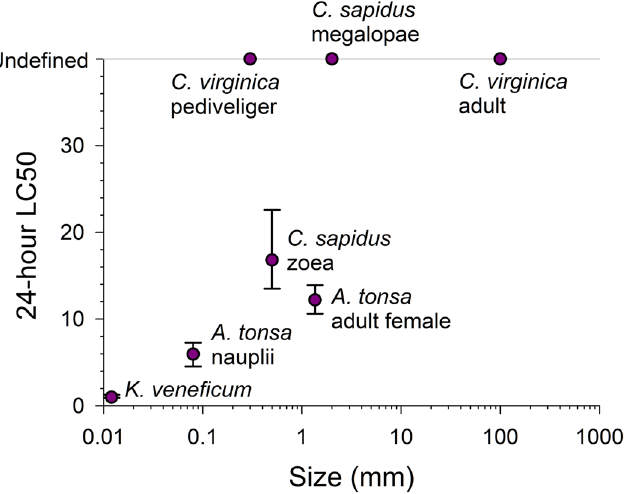
Figure 8. Size and 24-h LC50 for various animal species, as well as the EC50 for the harmful dinoflagellate Karlodinium veneficum . Error bars are 95% CIs for LC50s. The grey line at the top is used to plot animals where a 24-h LC50 was not calculated. As size increases, generally so does